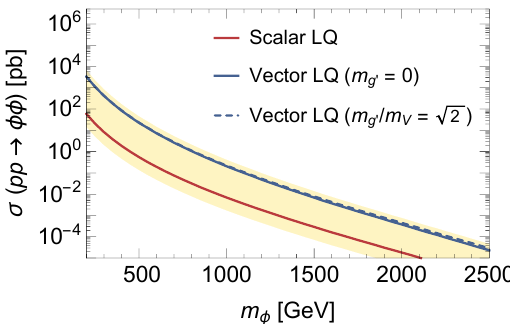
Figure 4 . Pair-production cross sections of LQs. Predictions are leading order (LO) with K -factors taken from [12, 13] ( K -factors have also been discussed in [14{16]). LO cross section were produced with CTEQ6 parton distribution functions and the renormalization scale (cid:22) = m (cid:30) . For simplicity, we applied the K -factors for scalars S also in the vector V case. For details of the vector model see appendix C. The cream band is explained in section